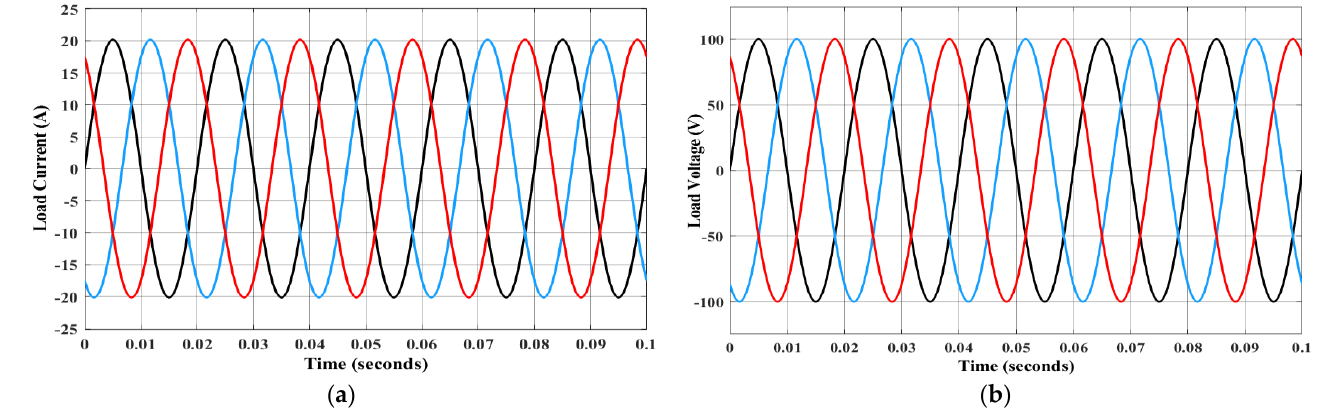
Figure 14. AC common bus current and voltage using the proposed technique: ( a ) current and ( b ) voltage signal.